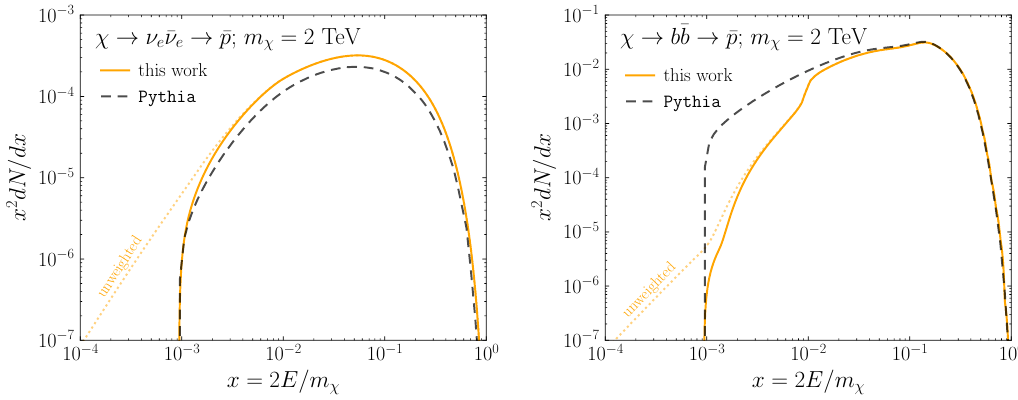
Figure 9 . Spectrum of antiprotons for two different initial states, electron neutrinos (left) and b -quarks (right), obtained for m χ = 2 TeV. Our default results, labelled “unweighted”, continue to unphysical x -values. In appendix D.2 we outline a weighting procedure to correct these to the solid orange curves. Even then, residual features at x ∼ m remain, although they are washed out p /q W for larger masses. This feature is a result of the incomplete treatment of the proton mass in this work, see text for